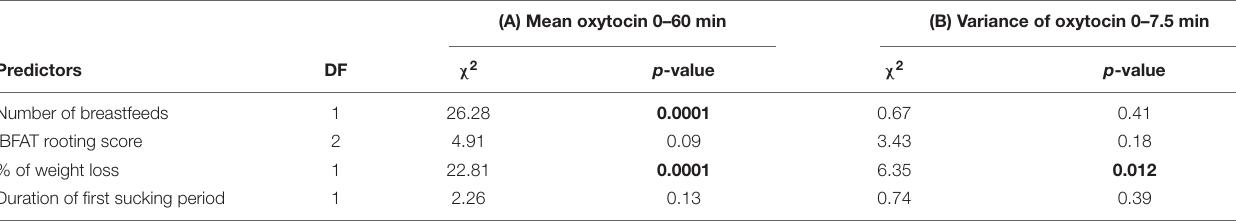
FIGURE 2 | (A) Shows maternal mean ( ± SE) plasma levels of oxytocin (pg/mL) from 0 to 60 min during the observed breastfeed in mothers 2 days after birth in the different intervention groups: CTRL, OT iv, OT im, EDA w ithout OT iv or EDA with OT iv. Logistic regression analysis using a generalized linear model (PROC GENMOD) with a post hoc test where pair wise comparisons between groups were performed: CTRL vs. EDA with OT iv ( p < 0.05), OT iv vs. EDA with OT iv ( p < 0.05), OT im vs. EDA with OT iv ( p < 0.05) and EDA without OT iv vs. EDA with OT iv ( P < 0.01). (B) The figure shows maternal mean variance ( ± SE) of oxytocin (pg/mL) from 0 to 7.5 min during the observed breastfeed in mothers 2 days after birth in the different intervention groups: Logistic regression analysis using a generalized linear model (PROC GENMOD) did not find any significant effect of the medical interventions and therefore these data are only shown descriptively. TABLE 7 | The relationship between (A) maternal mean oxytocin levels 0–60 min (log transformed) and (B) oxytocin variance 0–7.5 min of the observed breastfeed 2 days after birth in the control group ( n = 12) alone and the following predictors; number of breastfeeds since birth ( < 7 or > 8), IBFAT Rooting score, % of weight loss in infants since birth (covariate), and duration of the first sucking period